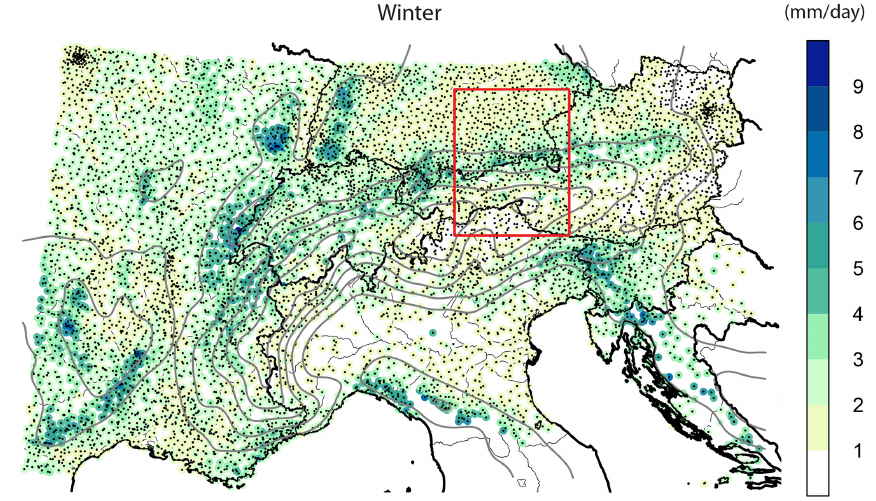
Figure 1. Map of long-term mean winter precipitation (mmday − 1 ) over the Alpine domain at station locations (dots) for the period 1971–2008. The grey contour lines indicate the Alpine relief (400m levels) and the red frame delimits the region in which the interpo- lation methods are